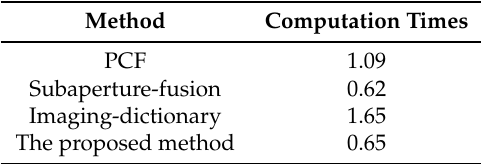
Table 2. The averaging computation time of 100 trials for four different multipath suppression methods.